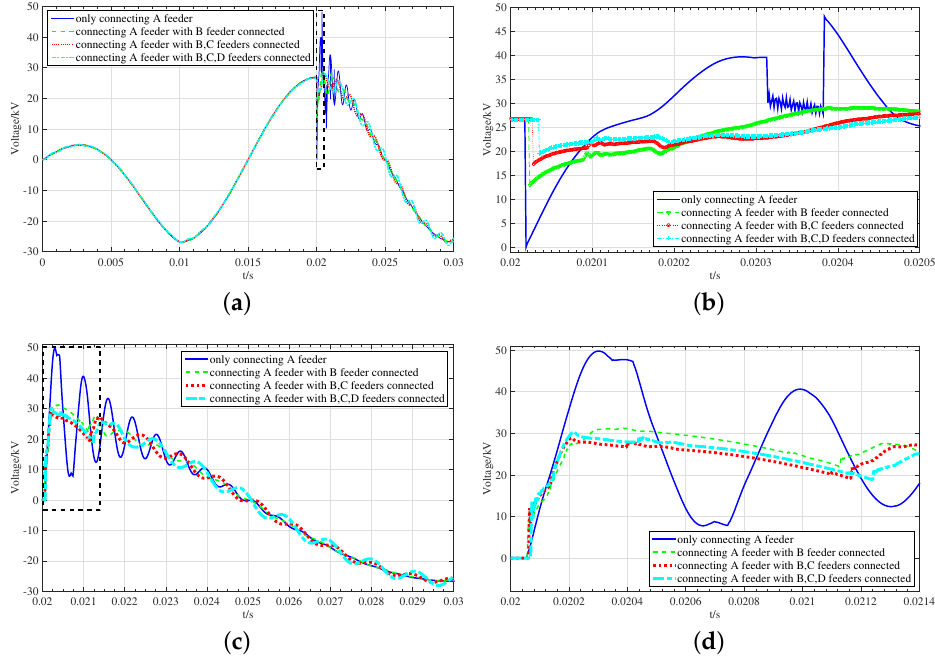
Figure 8. Voltage comparison of different connected radial number: ( a ) V pl comparison of different radial number; ( b ) magnified V pl comparison; ( c ) V WTT1 comparison of different radial number; and ( d ) magnified V WTT1 comparison.